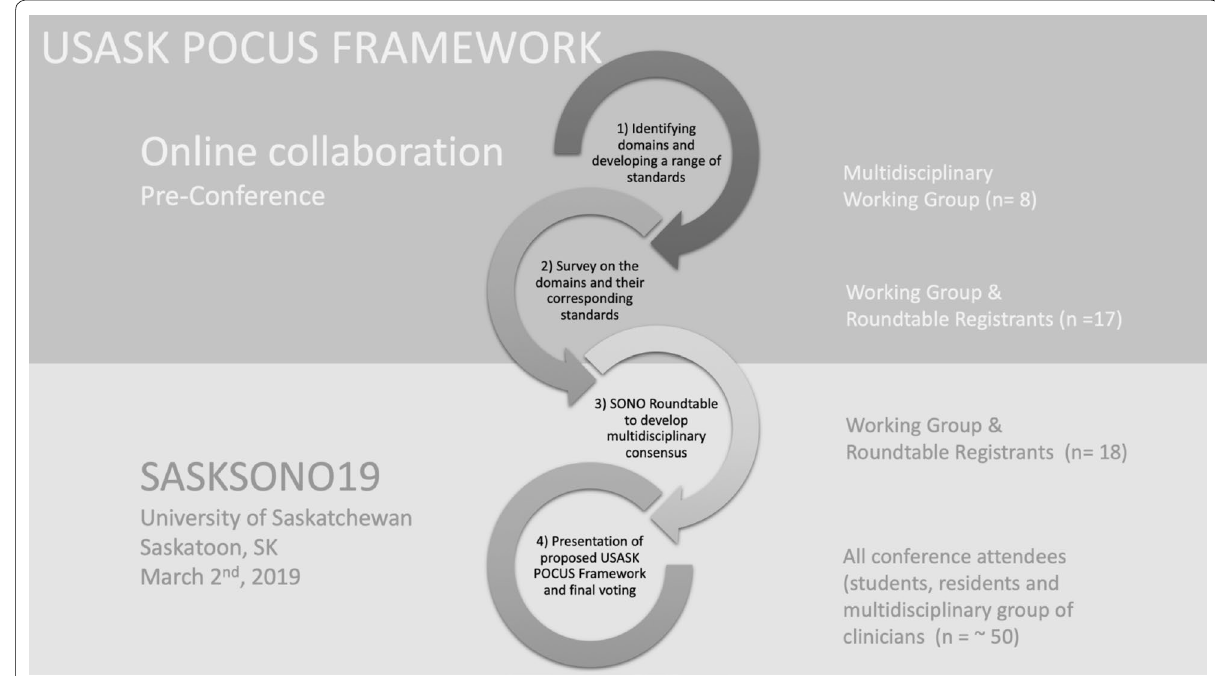
Fig. 1 Four-part process to draft and build consensus around a multidisciplinary framework of POCUS